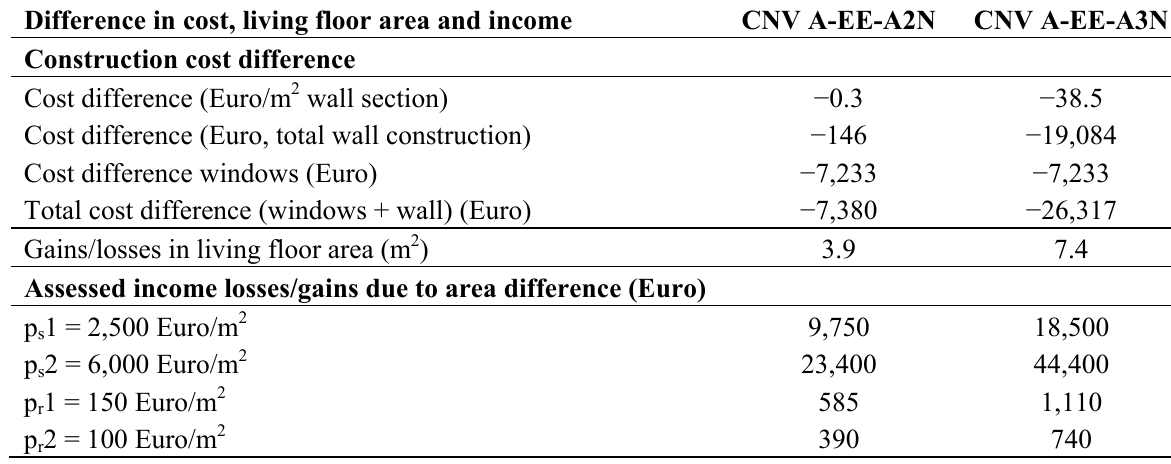
Table A2. Cost difference and assessed living area lost between conventional and energy-efficient building with new products constructed in 2013, timber house. Difference in cost, living floor area and income